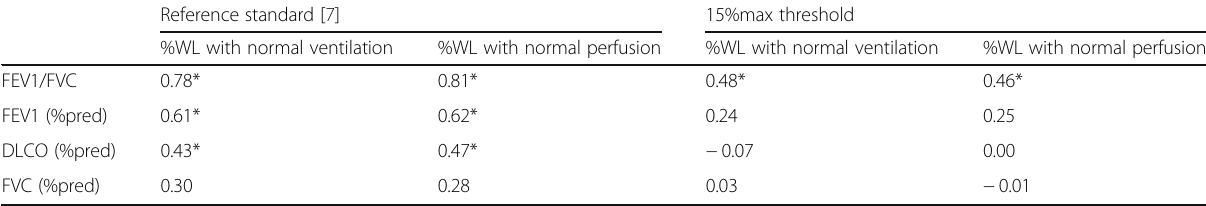
Table 2 Correlations of PFT parameters and 68 Ga-V/Q PET/CT functional volumes computed with the manual reference standard and the 15%max fixed